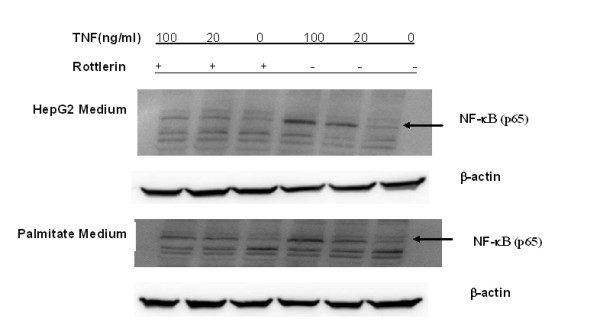
Effect of rottlerin on NF-κB measured by western blotting. Expression of phospho-P65 NF-κB in control and palmitate mediums with 0, 20, 100 ng/ml TNF-α, gith and without rottlerin (5 μM). TNF-α activated phospho-P65 NF-κB and this activation was attenuated with the PKC-δ inhibitor, rottlerin.